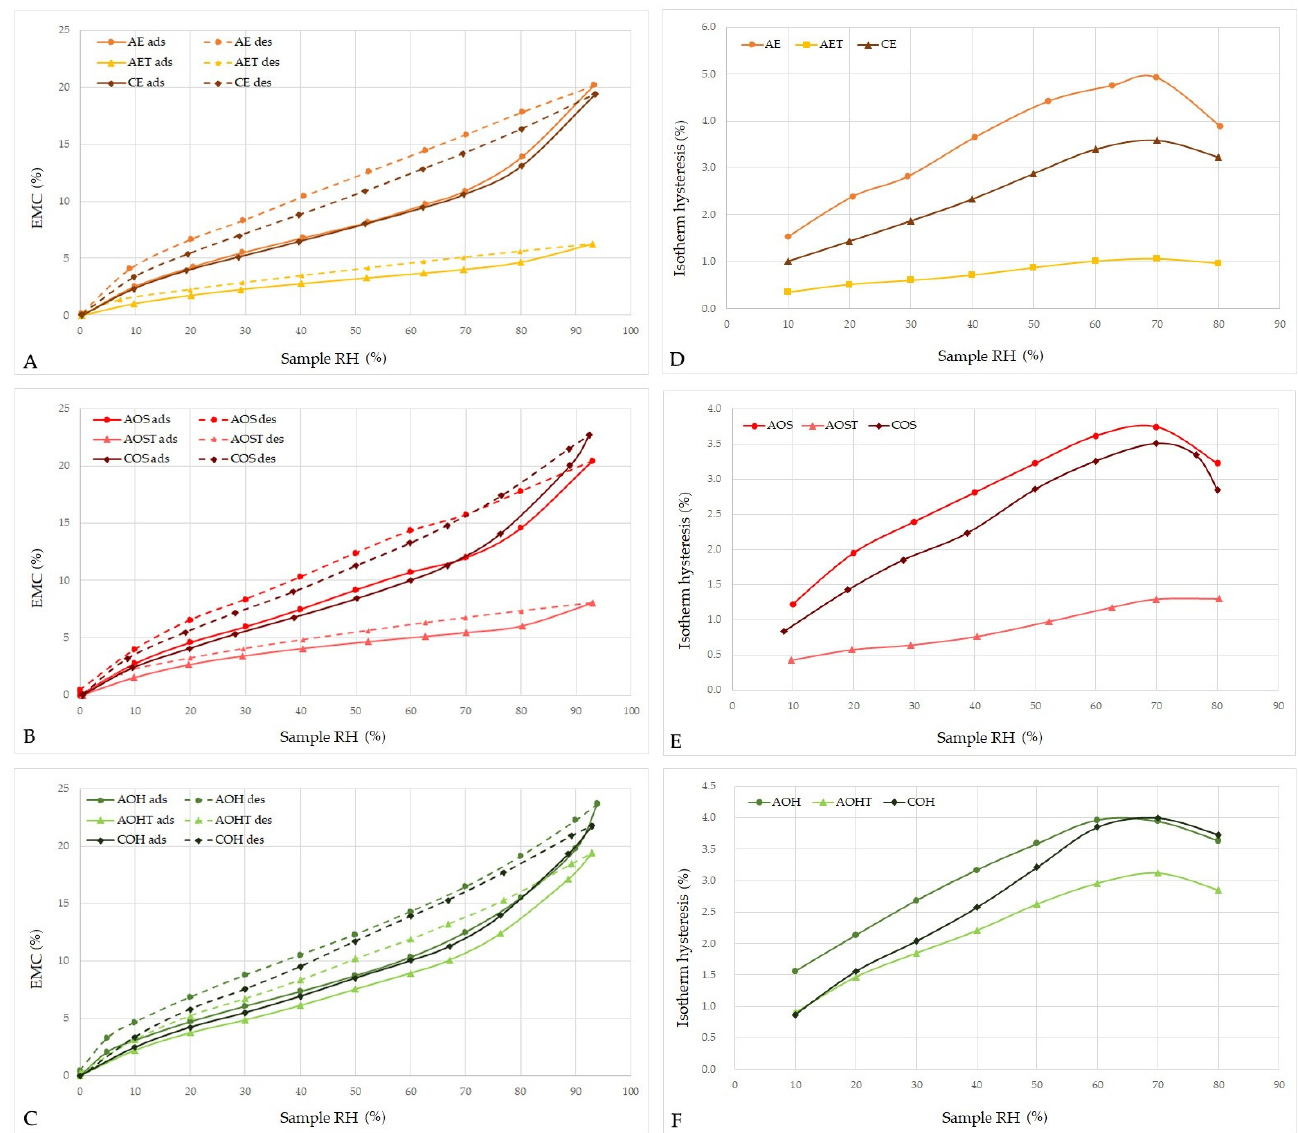
Figure 4. Sorption isotherms ( A – C ) and hysteresis ( D – F ) for air-dried contemporary and archaeological elm ( A , D ) and oak ( B , C , E , F ) wood samples (untreated and treated with MTMS); ads—adsorption, des—desorption.